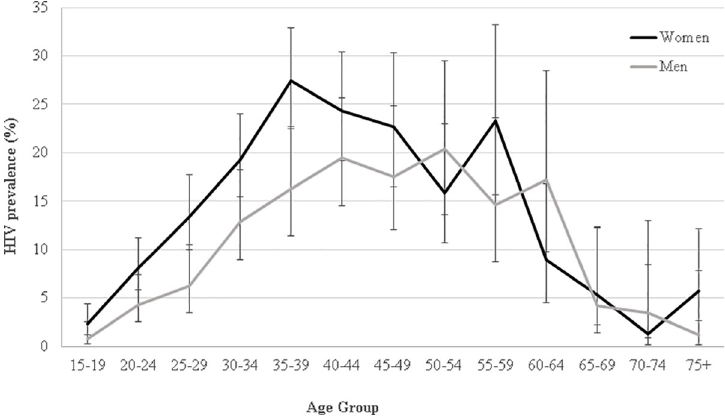
Fig 2. HIV prevalence by five-year age group among men and women, Nsanje District, Malawi